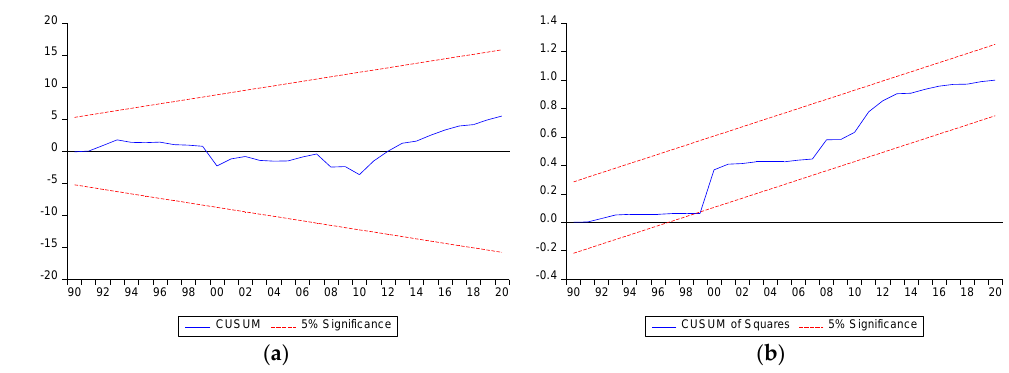
Figure 10. ( a ) CUSUM Test for Model 4. ( b ) CUSUMQ Test for Model 4. Cumulative Dynamic Multipliers The study has analyzed the compelling effects of CFD and CAD on OP and EP sepa- rately, using cumulative dynamic multipliers. Figure 11a,b illustrate the sequence of change in OP to its revised equilibrium as a result of positive and negative shocks to the CFD and CAD. In each figure, the continued black line shows positive shocks, the dotted black line exhibits negative shocks, and the dark red dotted line represents the asymmetry plot. In Figure 11a, it can be asserted that the dynamic effects of CFD+ and CFD- on OP are diametrically opposed, indicating the existence of fiscal deficit asymmetries. Figure